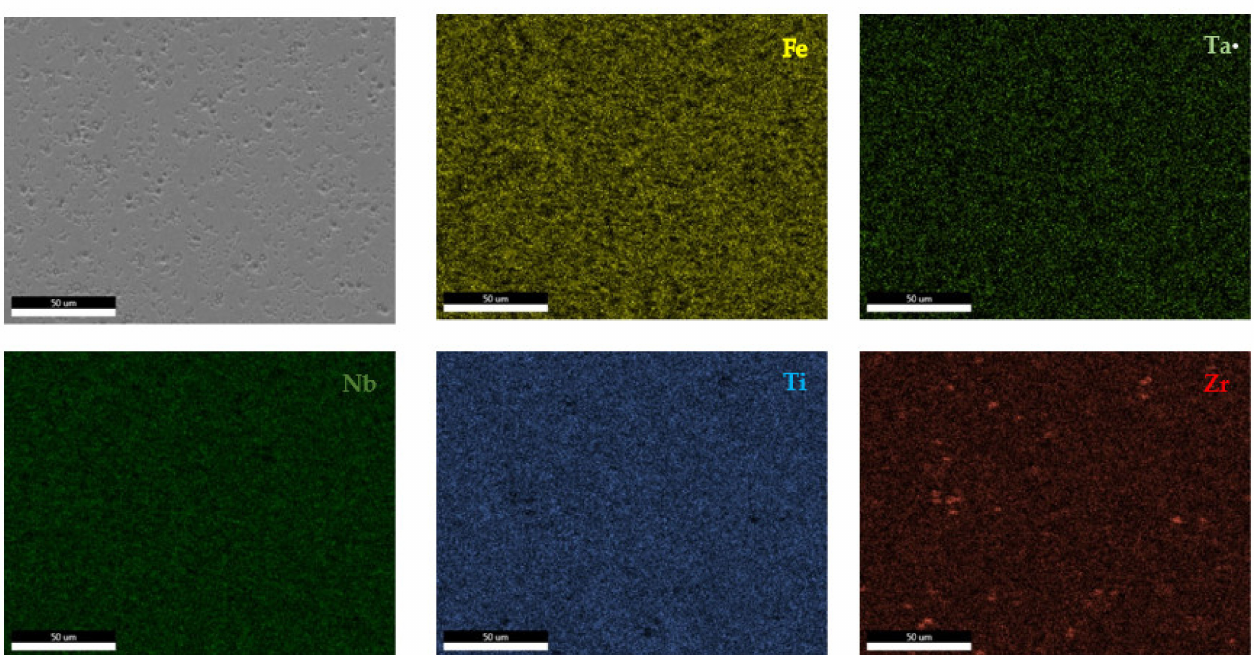
Figure 11. EDS mapping of the FeTa 0.5 Nb 0.5 Ti 1.5 Zr 0.5 alloy.